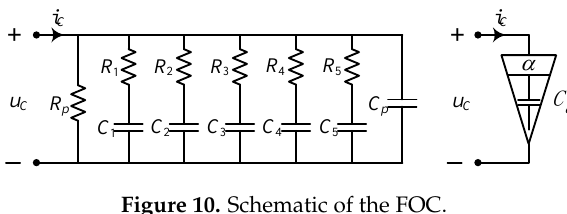
Figure 10. Schematic of the FOC.